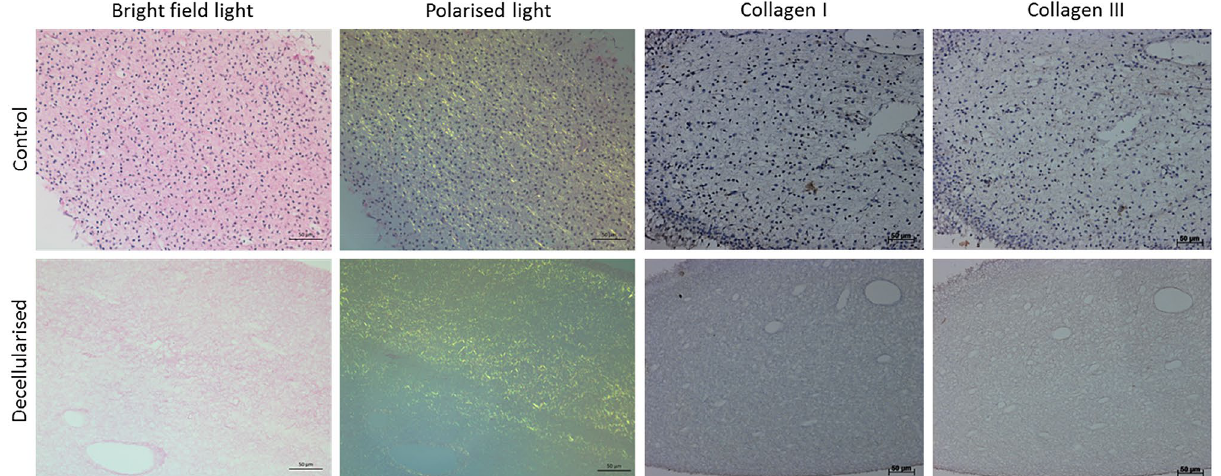
Figure 2. Collagen structure assessment. Representative images of rat dental pulp tissues stained with picrosirius red, labelled with collagen type I and III antibodies. Control tissues reveal a porous collagen matrix, mainly composed of immature collagen fibres (stained green under the polarised light), and a weak positive immunoreactivity to collagen type I and III antigens. Following decellularisation, preservation of an acellular porous collagen matrix and a positive, but reduced, staining pattern of collagen type I and III fibres in comparison to the control tissues was evident. Scale bars are at 100 and 50 µm.